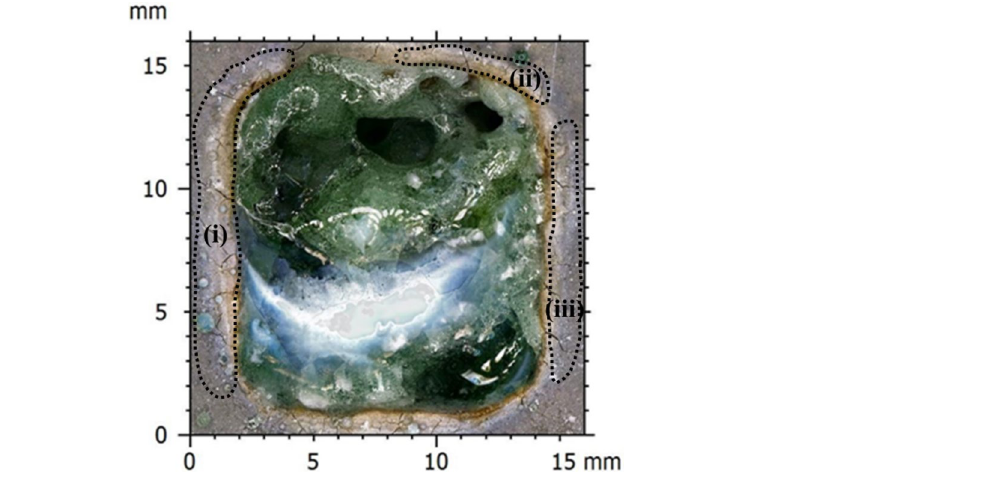
Figure 12. (i–iii) Top surface HAZ, cracks appearance.